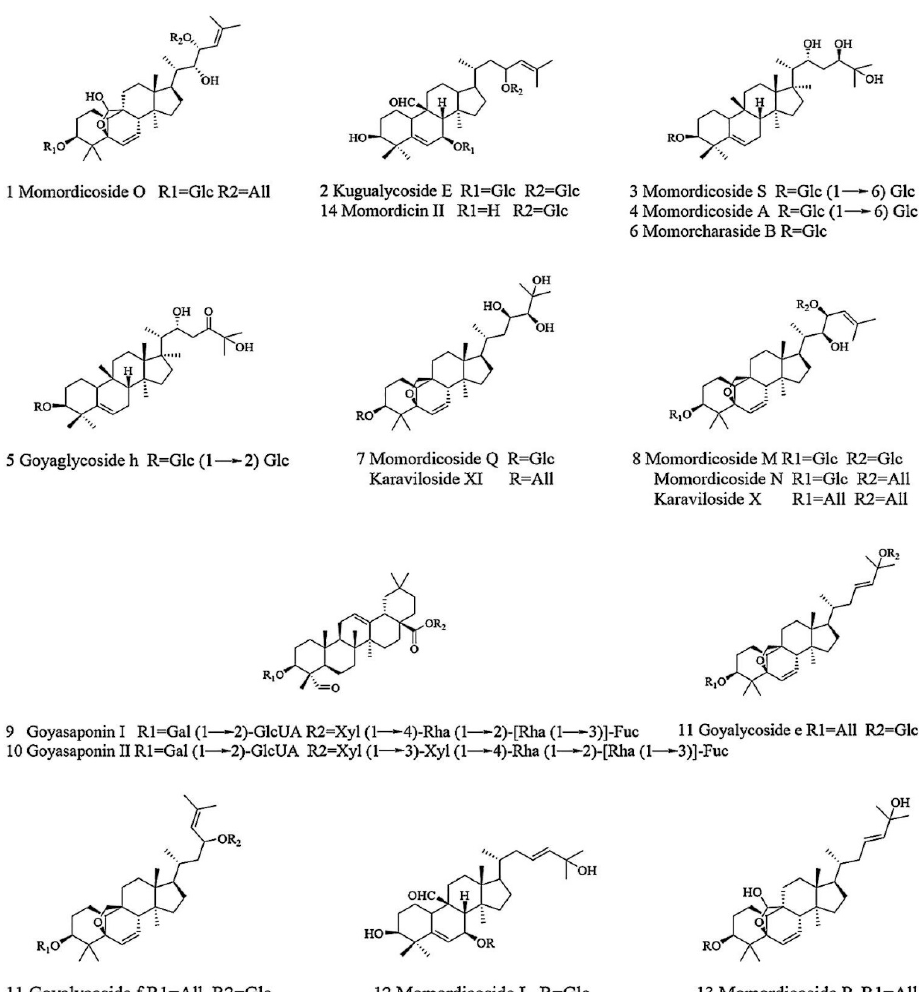
Figure 3. The structures of the compounds identified in